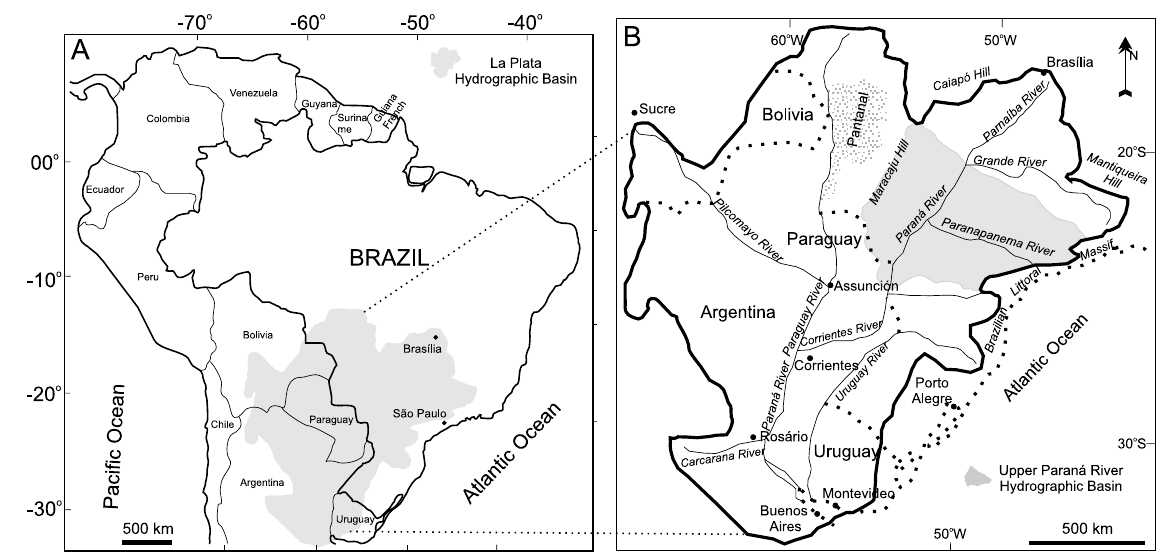
Fig. 1 – Geographic location map of the La Plata Hydrographic Basin in South America (A), emphasizing the UPRHB (B). S TUDY A